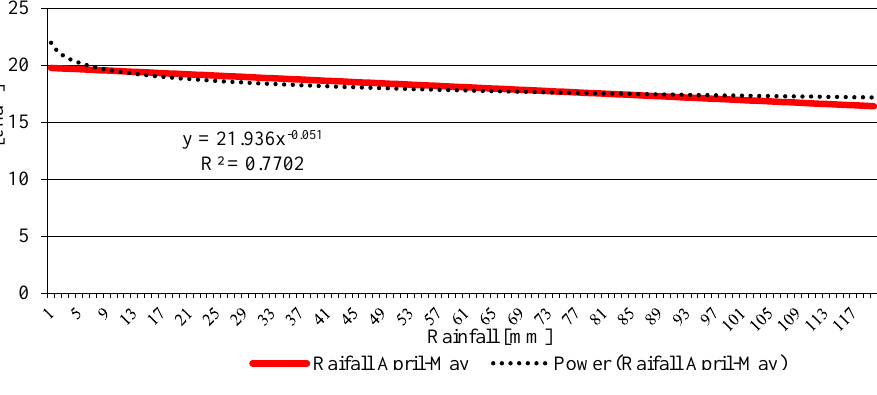
Figure 8. Partial dependence of tuber yield on total rainfall in April – May. The results of polynomial regression analysis of tuber yield versus rainfall total,